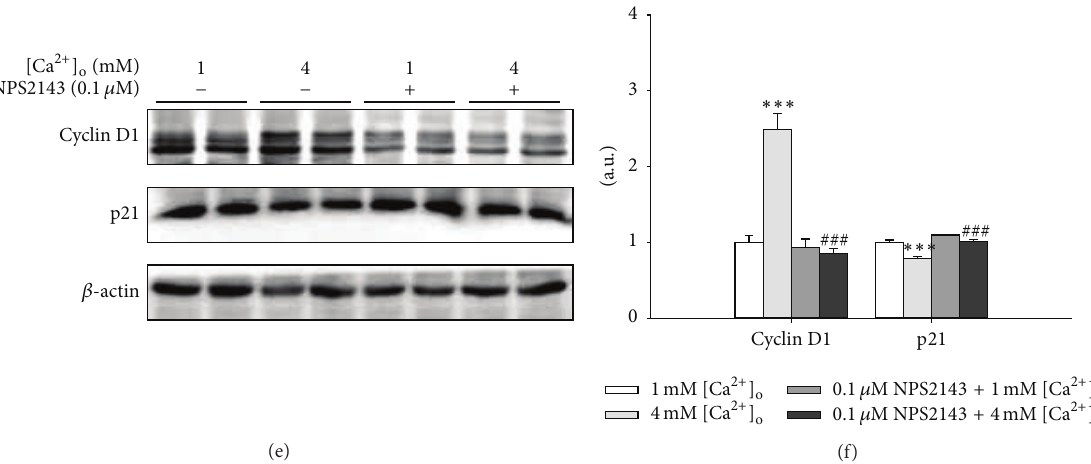
Figure 2: Inhibition of CaSR reversed the promotive effects of [ Ca 2+ ] o on the proliferation of pBMSCs. (a) Effects of NPS2143 (0.1 𝜇 M), an antagonist of CaSR, on the proliferation of pBMSCs after 5-day incubation ( 𝑛 = 8 ). (b) Effects of 4mM [ Ca 2+ ] o and/or 0.1 𝜇 M NPS2143 on the cell cycle progression of pBMSCs. After pBMSCs were exposed to 4mM [ Ca 2+ ] o with or without NPS2143 (0.1 𝜇 M) for 5 days, the cells were collected and treated according to the protocol in Materials and Methods. The DNA contents were measured with FACScan flow cytometry. (c) Analysis of proliferation index (PI) and the percentage of cells in G0/G1, S, and G2/M phases. (d) The mRNA expression levels of cyclins (cyclin A2, cyclin D3, and cyclin E2), PCNA, and p21 in response to 4mM [ Ca 2+ ] o and/or 0.1 𝜇 M NPS2143. (e) Western blot analysis of cyclin D1 and p21 in pBMSCs after 5-day culture. 𝛽 -actin was used as loading control. (f) Mean ± SEM of immunoblotting bands of cyclin D1 and p21; the intensities of the bands were expressed as the arbitrary units ( 𝑛 = 4 ). ∗ 𝑃 < 0.05 , ∗∗ 𝑃 < 0.01 , and ∗∗∗ 𝑃 < 0.001 versus 1mM [ Ca 2+ ] o group (control); # 𝑃 < 0.05 , ## 𝑃 < 0.01 , and ### 𝑃 < 0.001 versus 4mM [ Ca 2+ ] o